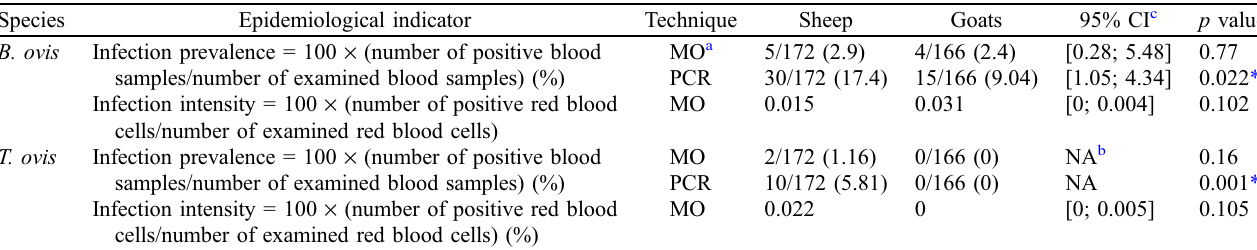
Table 2. Theileria ovis and Babesia ovis infection prevalence and intensity in sheep and goats by Giemsa-stained blood smears and PCR in Aı¨n Draham, North-West